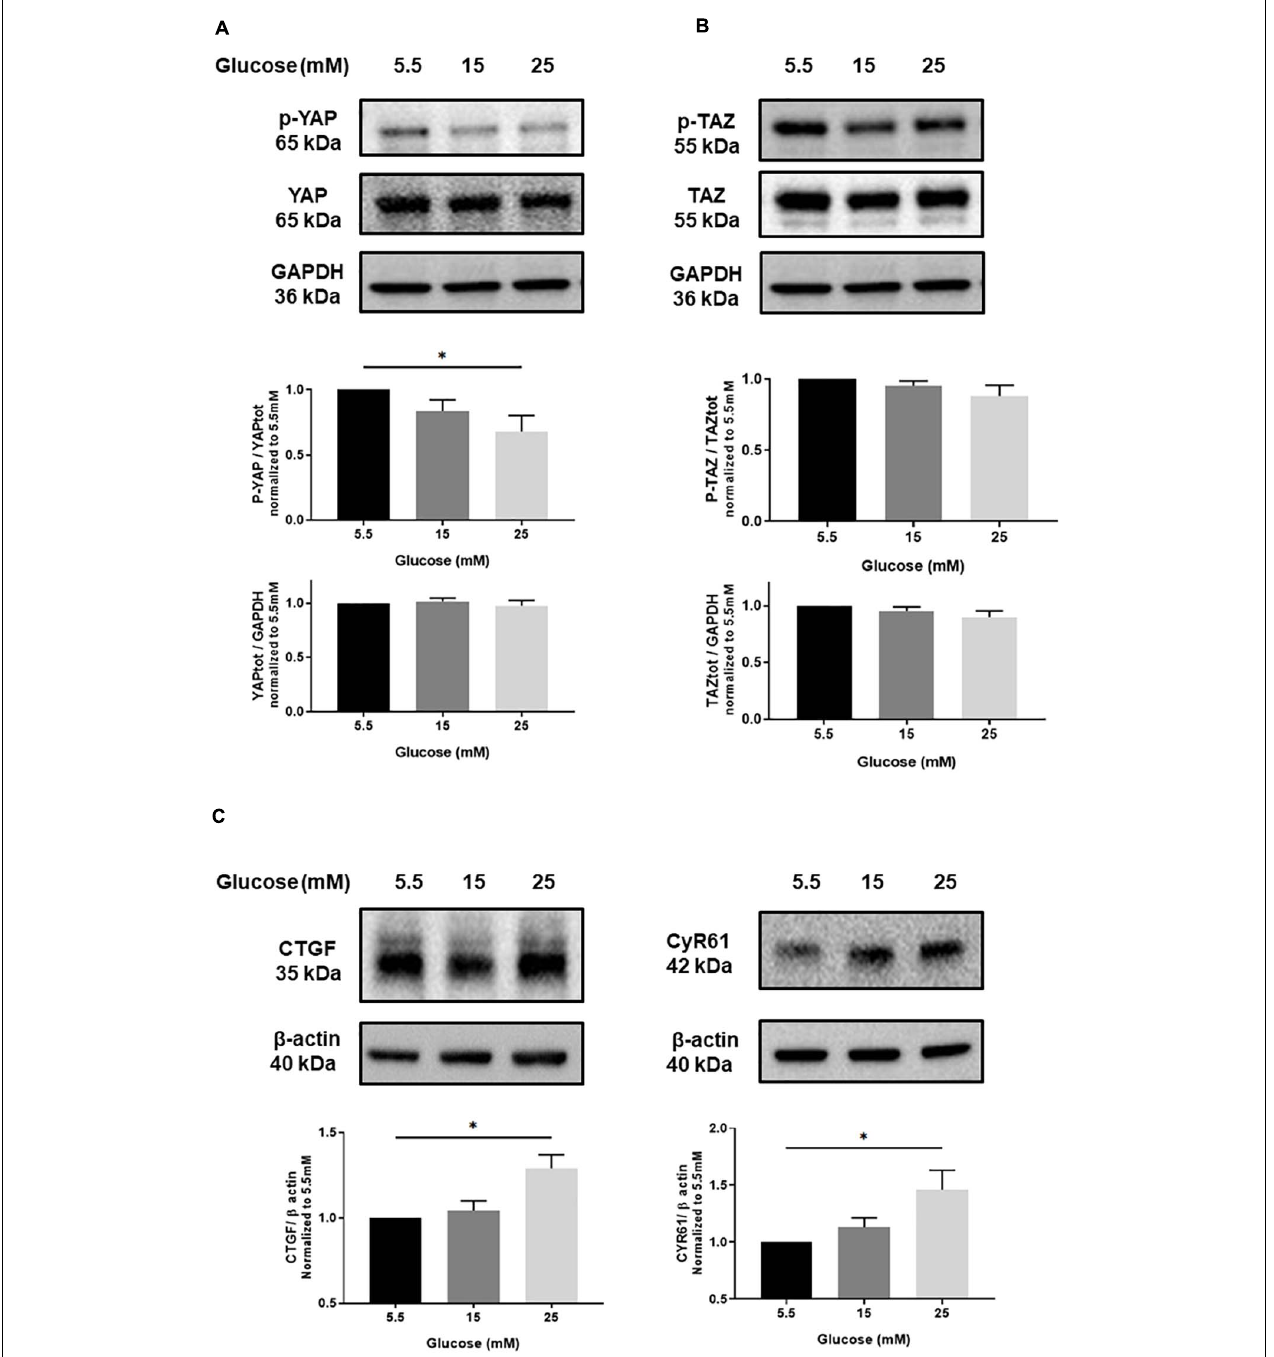
FIGURE 1 | Effect of high glucose on YAP activation in endothelial cells. Representative protein expression blots and bar graphs of phospho-YAP (p-YAP; S127) and total YAP (A) , phospho-TAZ (p-TAZ; S89) and total TAZ (B) , CTGF and CYR61 (C) in HUVECs cultured under static conditions with different concentrations of glucose for 24 h. The control images of GAPDH are re-used for illustrative purposes. Data are presented as the mean ± SEM. N = 5/group for panels A and B; N = 7/group for panel C. * p < 0.05 between the indicated groups. Two-tailed Student’s t test was used for comparisons between the